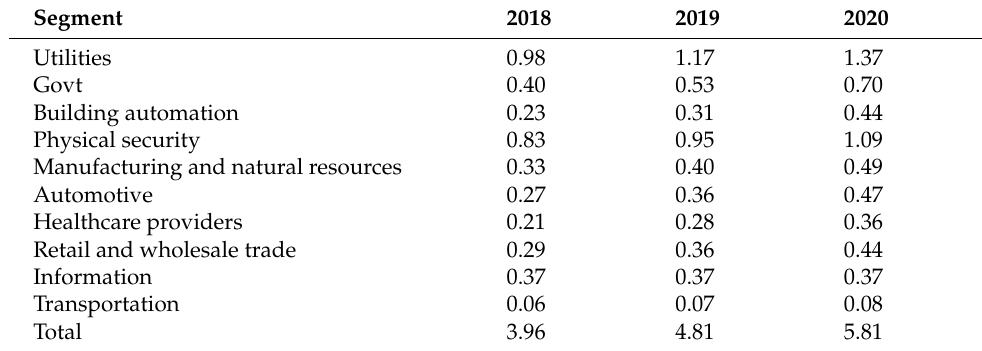
Table 1. IoT endpoint market by segment, 2018–2020, worldwide (in billions) [1].